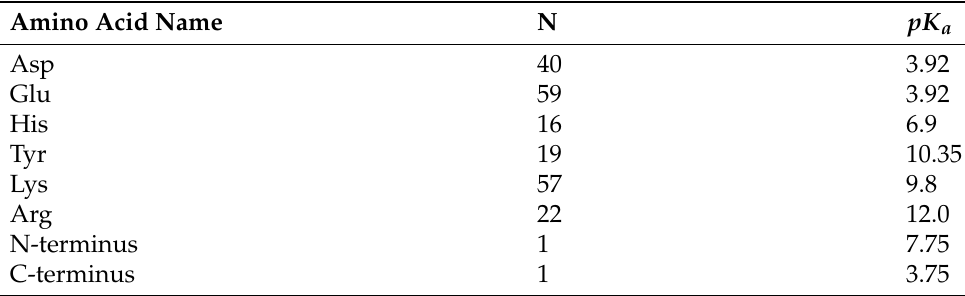
Table 1. Values of pK a and numbers (N) of each charge group for BSA [35].